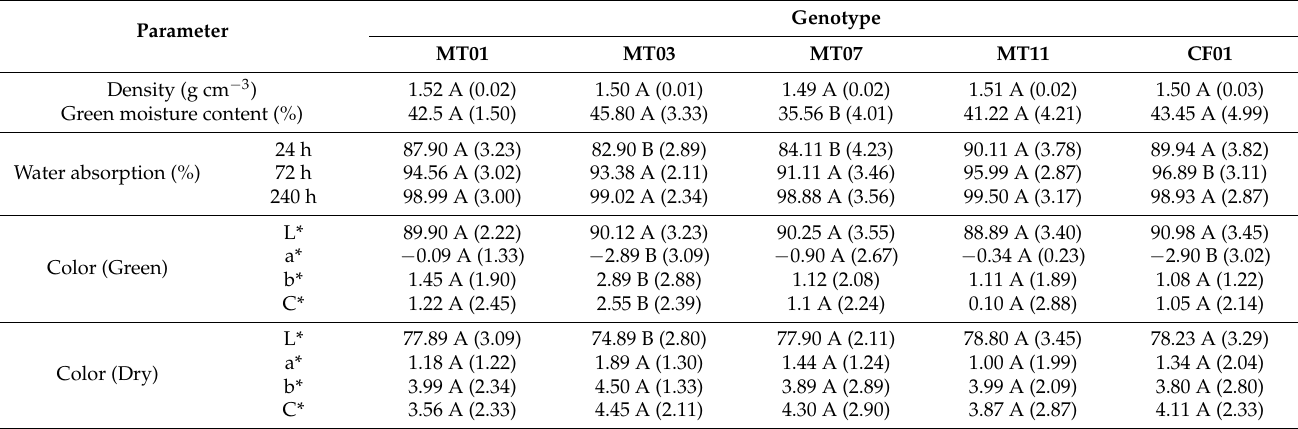
Table 1. Fiber physical properties of five genotypes of M. textilis